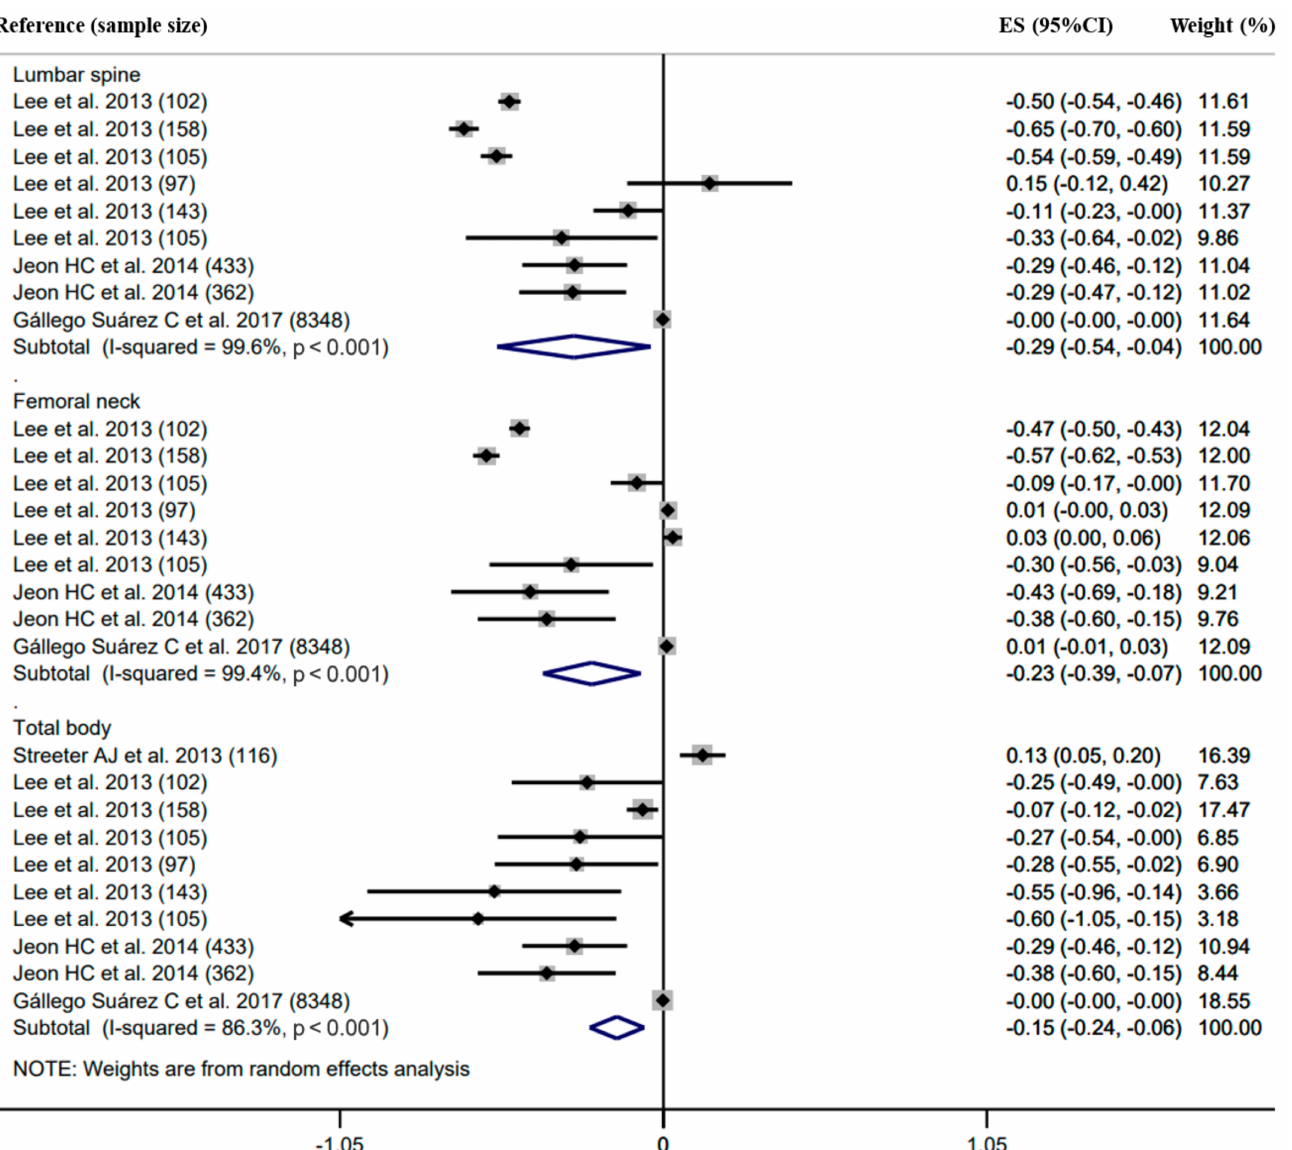
Figure 4. Forest plot of association (regression coefficient) between body fat percentage (BF%) and bone mineral density (BMD) in lumber spine, femoral neck and total body, respectively. The effect size (ES) and 95% confidence interval (CI) for fully adjusted random effects are depicted for each